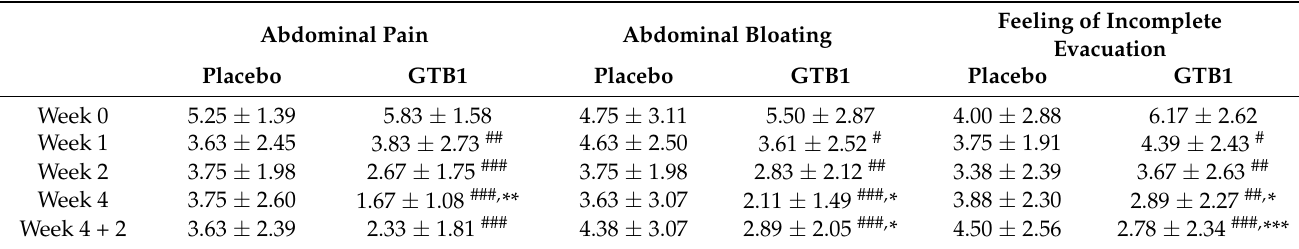
Table 2. Comparison of intestinal discomfort symptoms during study periods.